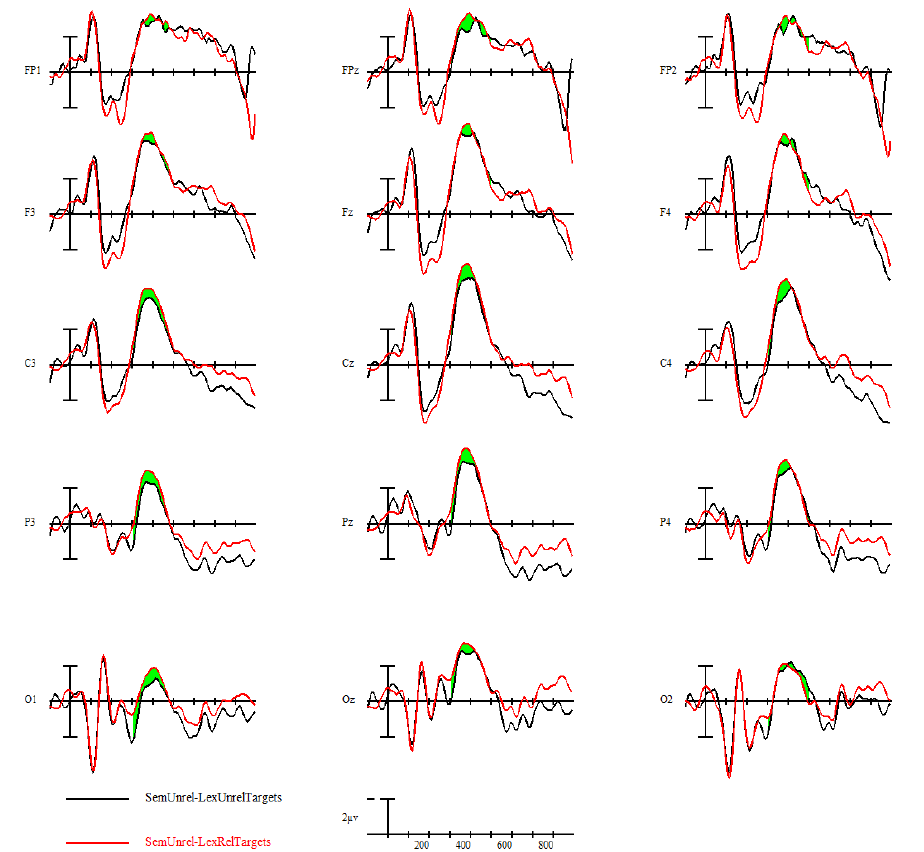
Brain Sci. 2019 , 9 , x FOR PEER REVIEW Figure 9. L1 translation lexical priming effect in semantically unrelated conditions. Figure 9. L1 translation lexical priming e ff ect in semantically unrelated conditions.